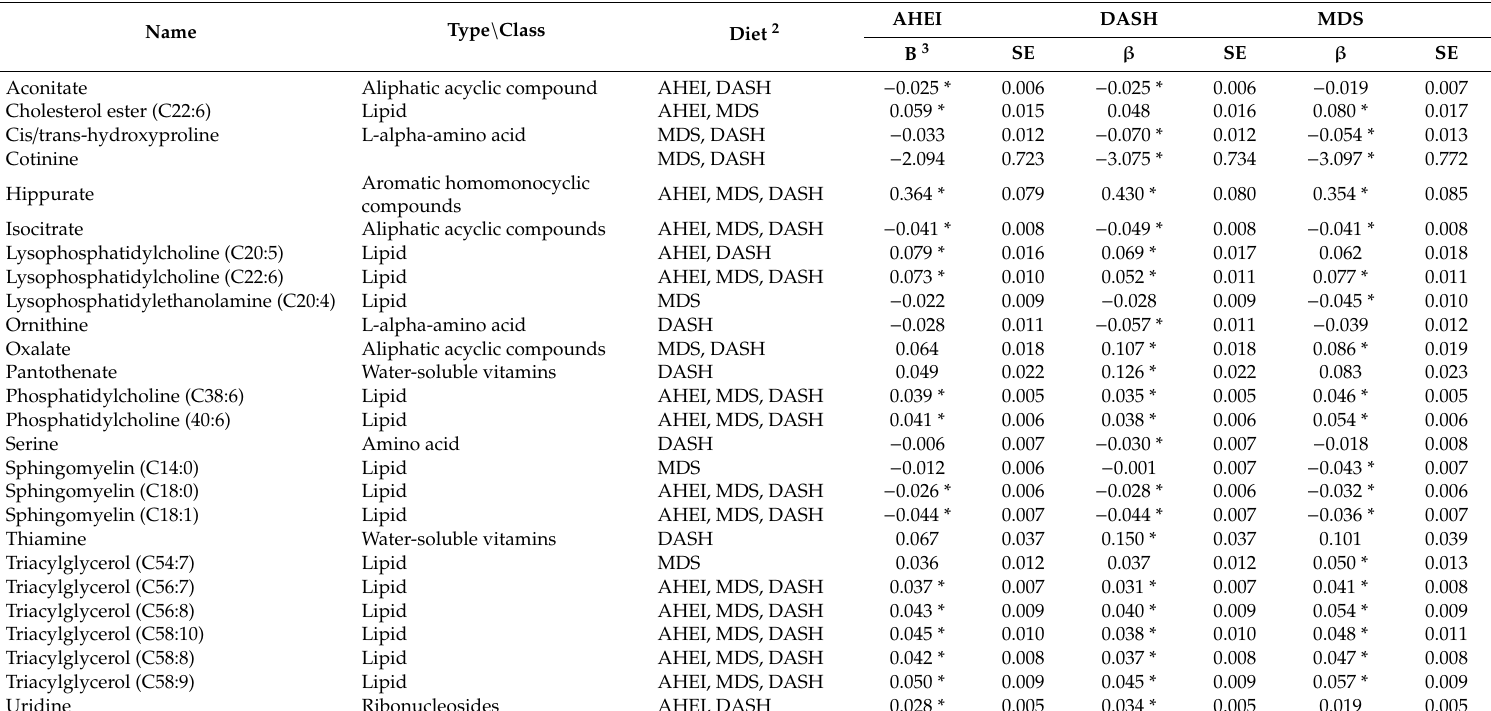
Table 3. Top significant associations of dietary patterns with plasma metabolite concentrations